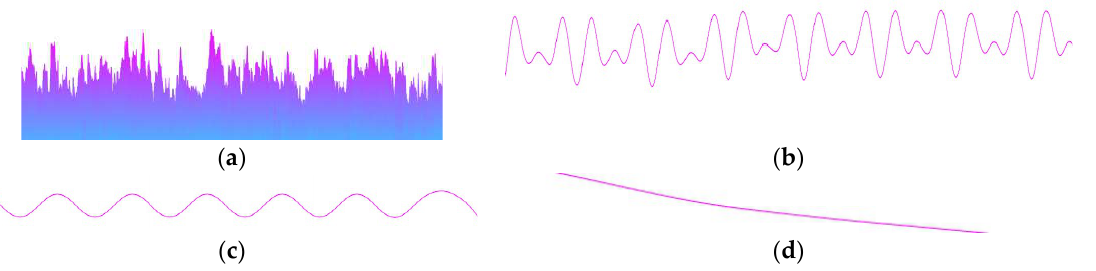
Figure 4. Signal to be measured on the outer surface of ceramic ball, including ( a ) signal to be measured, ( b ) surface roughness error signal, ( c ) waviness error signal, and ( d ) sphere form deviation signal.